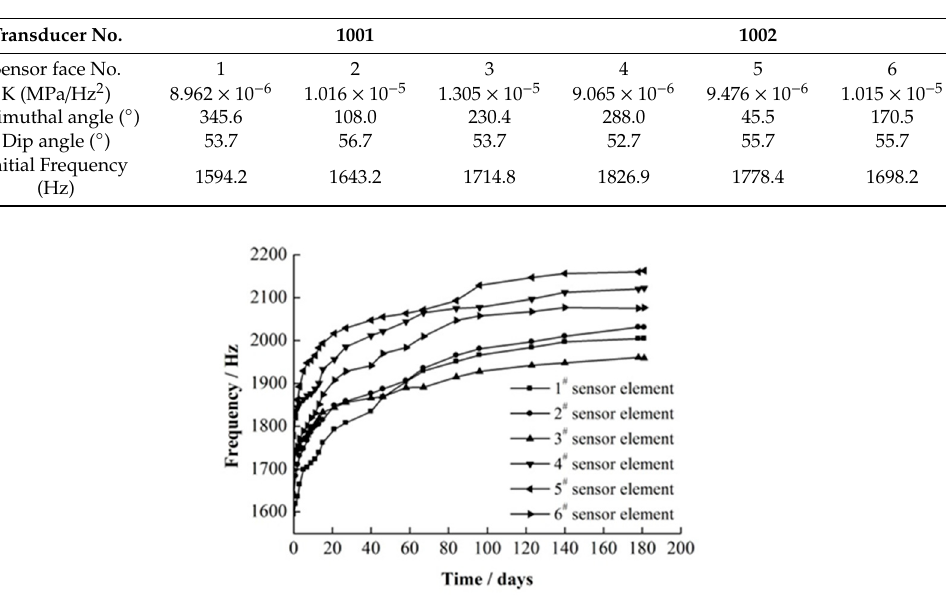
Table 3. Information for transducers embedded in PDS No. 1 coal mine.